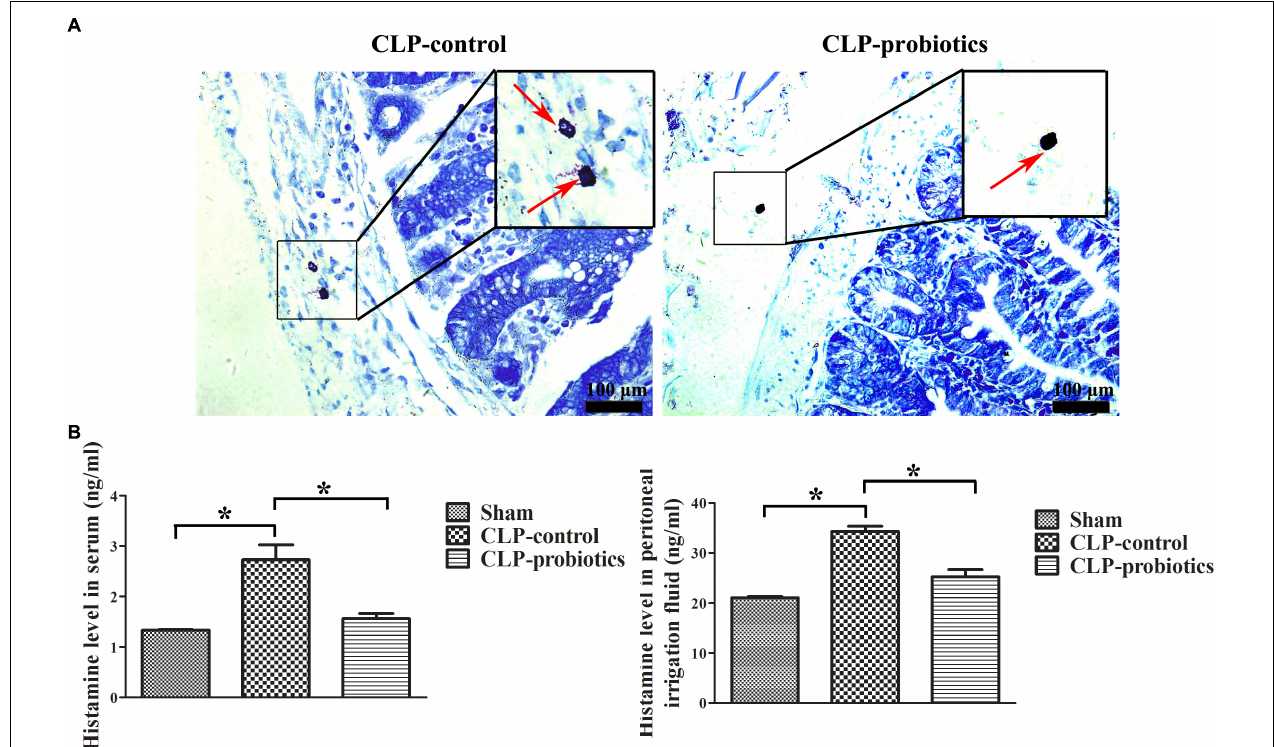
FIGURE 6 | The effect of LCBE pretreatment on MCs degranulation and histamine secretion. (A) The representative images of toluidine blue staining to identify the degranulation of MCs. The degranulation of MCs was marked by red arrow. (B) The histamine contents in serum and peritoneal lavage fluid were measured by ELISA. All data were illustrated as means ± SEM. N = 6 mice/group; ∗ P <